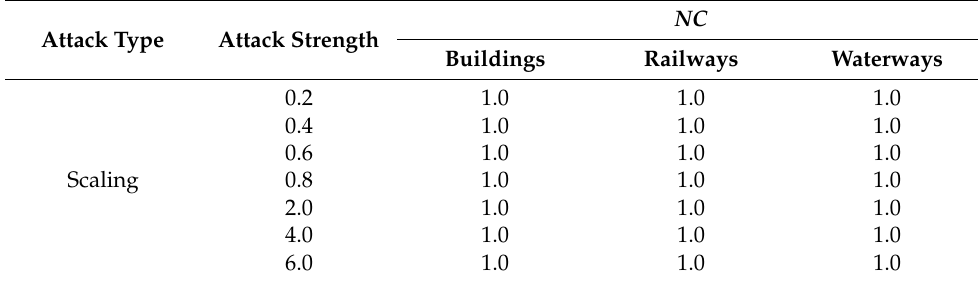
Table 9. The robustness results of scaling attack.